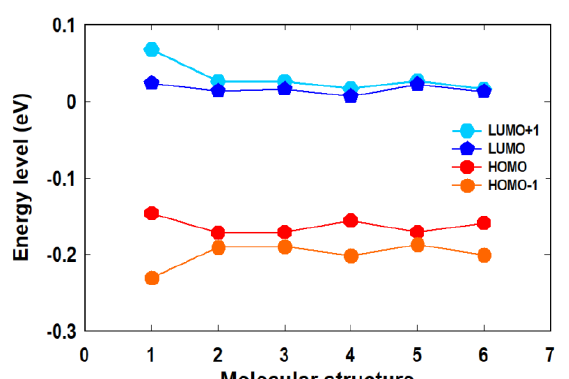
Figure 2: Comparison of the calculated energy levels of family molecular groups.